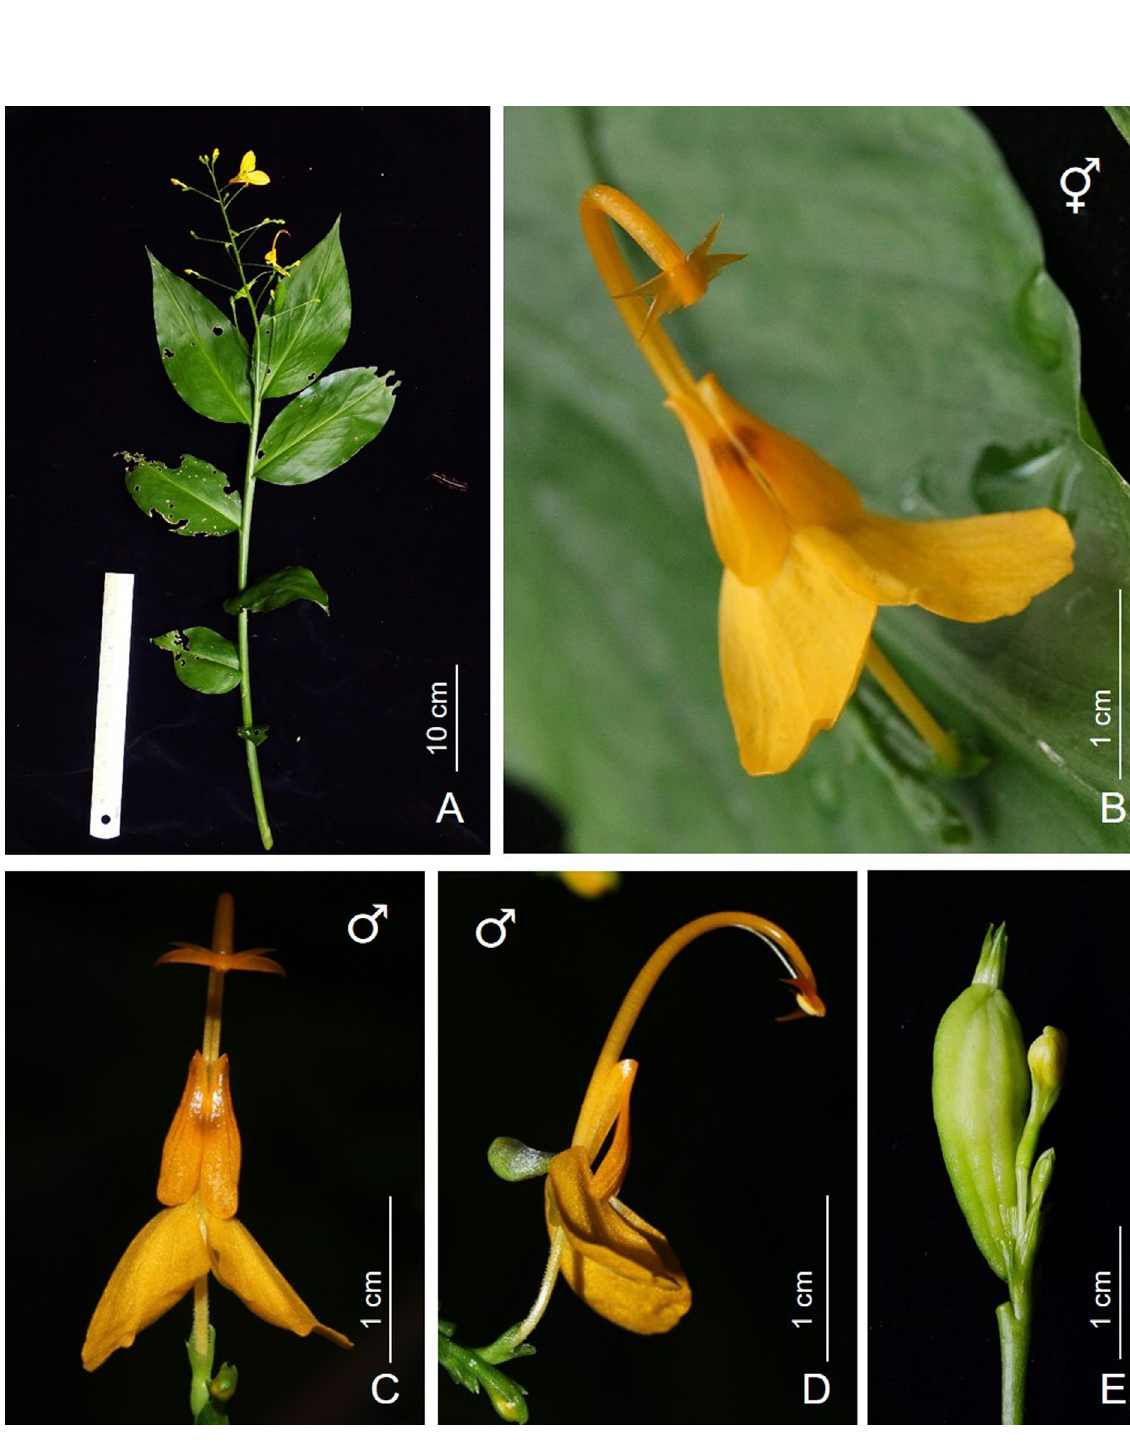
Fig. 5. Globba aranyaniae Sangvir. & M.F.Newman sp. nov. A . Habit. B . c flower. C . ♂ flower (front view). D . ♂ flower (side view). E . Fruit. Photographs: A, E, J.L. Škorničková from J.L. Škorničková 1688 leg.; B–D, S. Sangvirotjanapat from S. Sangvirotjanapat 785